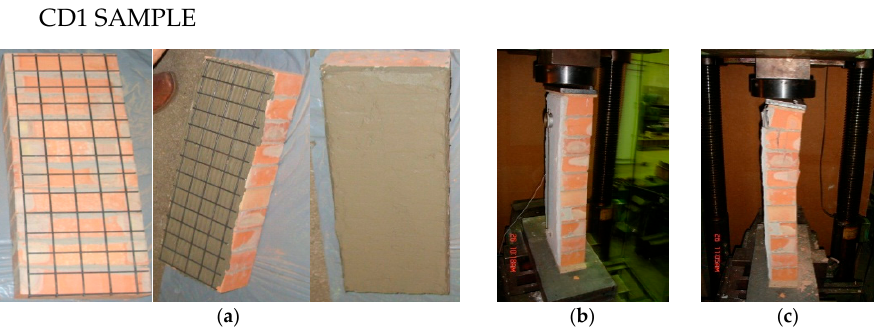
Figure 4. Masonry segment made of ceramic bricks, cross-section 12 × 25 cm, reinforced with a steel mesh: ( a ) from preparation; ( b ) under load; ( c ) destruction.